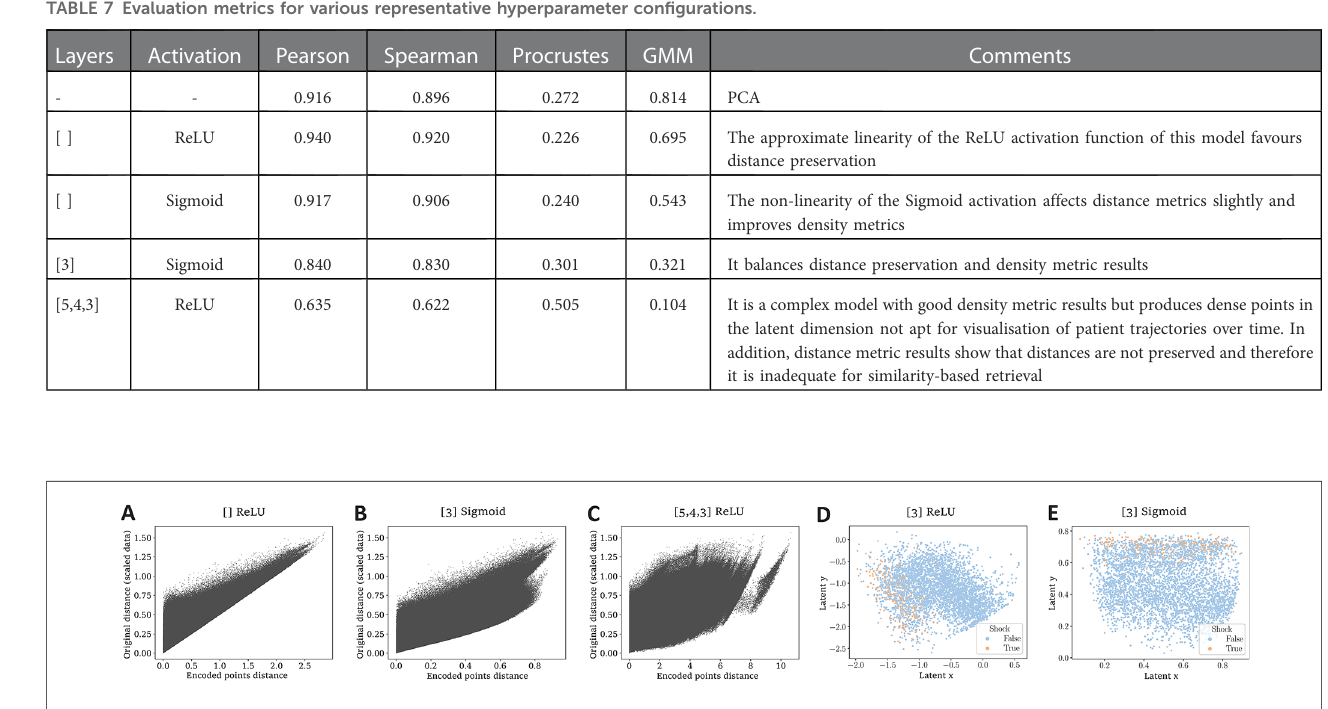
FIGURE 3 Sheppard diagrams (left) and shock label projections (right). On the left, Sheppard diagrams obtained for autoencoders with A) no hidden layers and ReLU activation, B) one hidden layer with 3 nodes and Sigmoid activation, and C) three hidden layers with 5, 4, and 3 nodes respectively, and ReLU activation. On the right, the distribution of patients in the latent space using an autoencoder with D) one hidden layer with 3 nodes and ReLU activation and E) one hidden layer with 3 nodes and Sigmoid activation. The color indicates whether the patient experienced (orange) or not (blue) an episode of shock during their hospital stay.